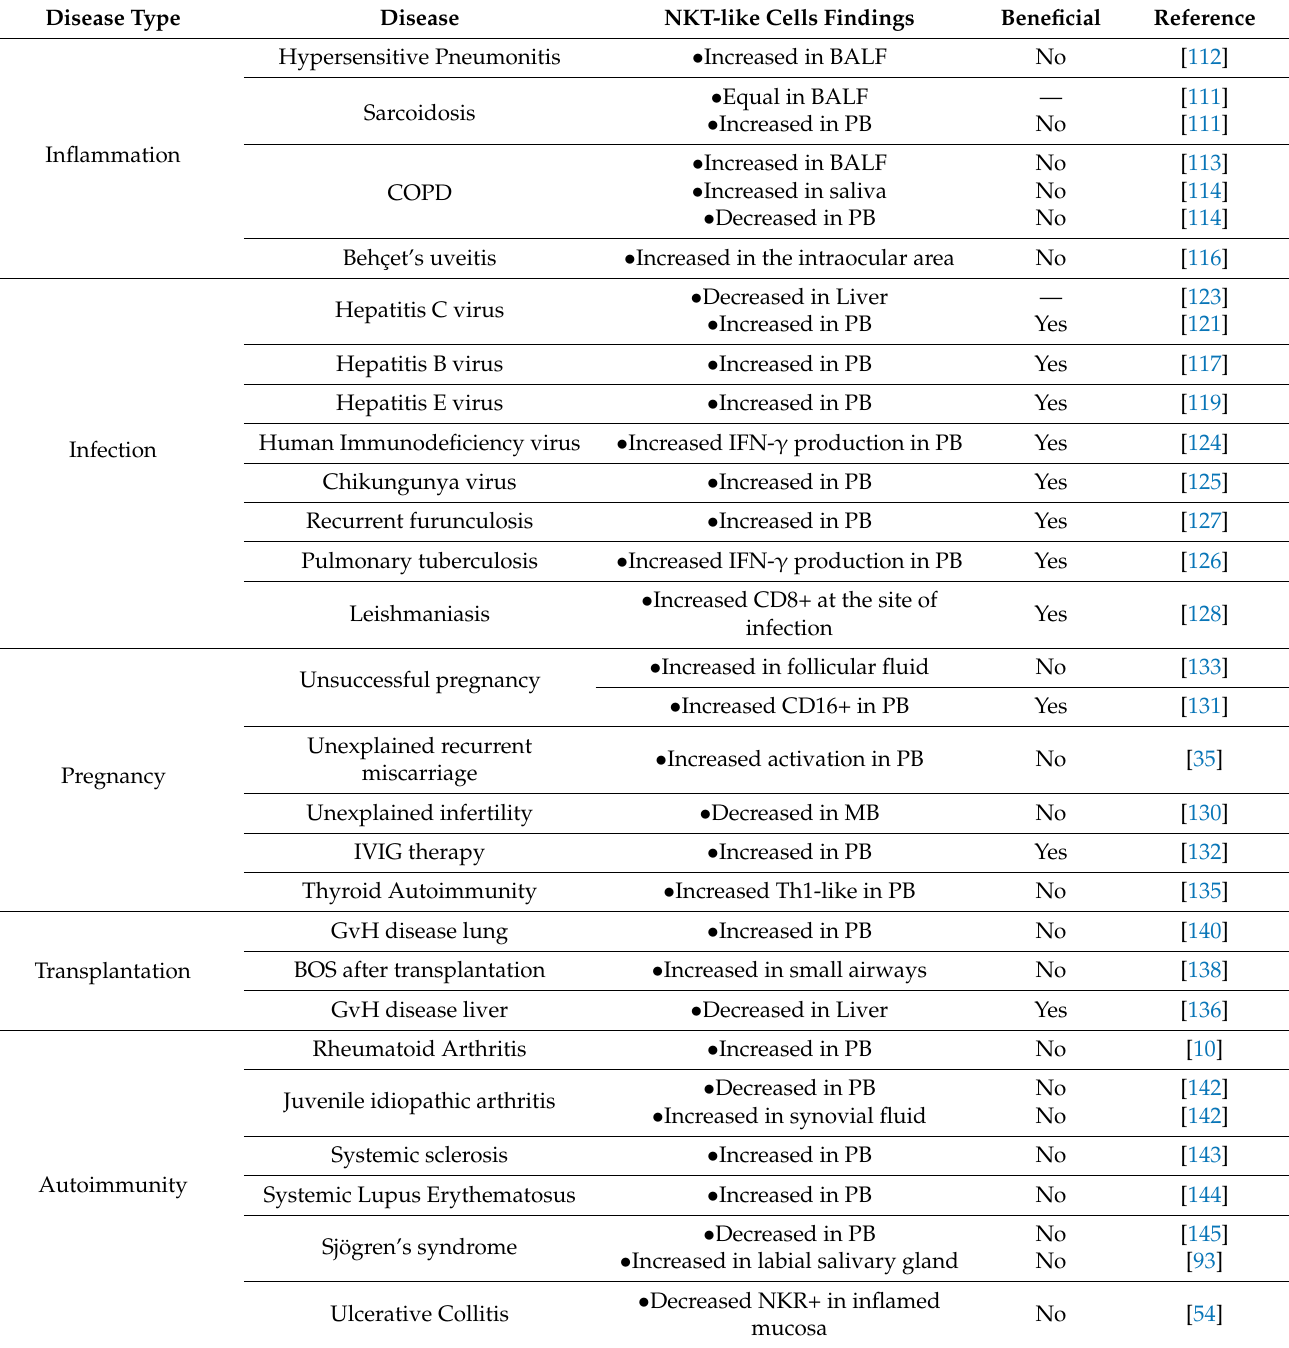
Table 1. Summary of previous studies evaluating the role of NKT-like cells in